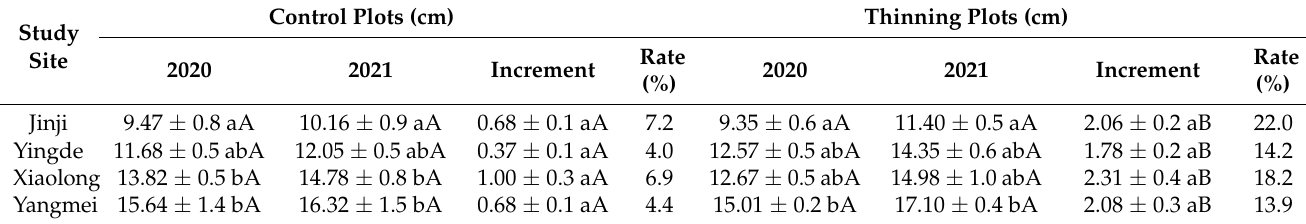
In the 11-year-old stands, the lowest volume was in Jinji (117.64 m 3 · ha − 1 , 101.83 m 3 · ha − 1 in control and thinning plots, respectively), with the highest forest